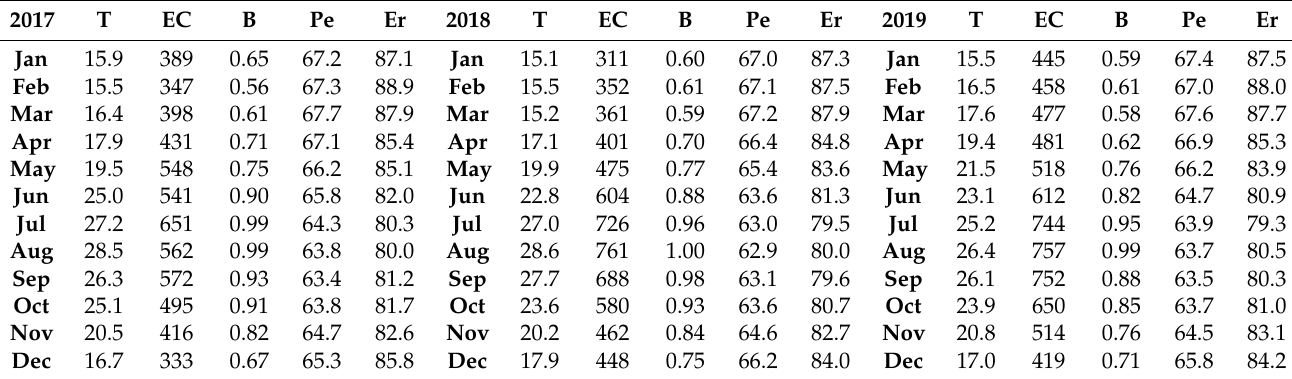
Table 1. Experimental records of temperature T ( ◦ C), electric conductivity (EC) ( µ S · cm − 1 ), permeate boron concentration